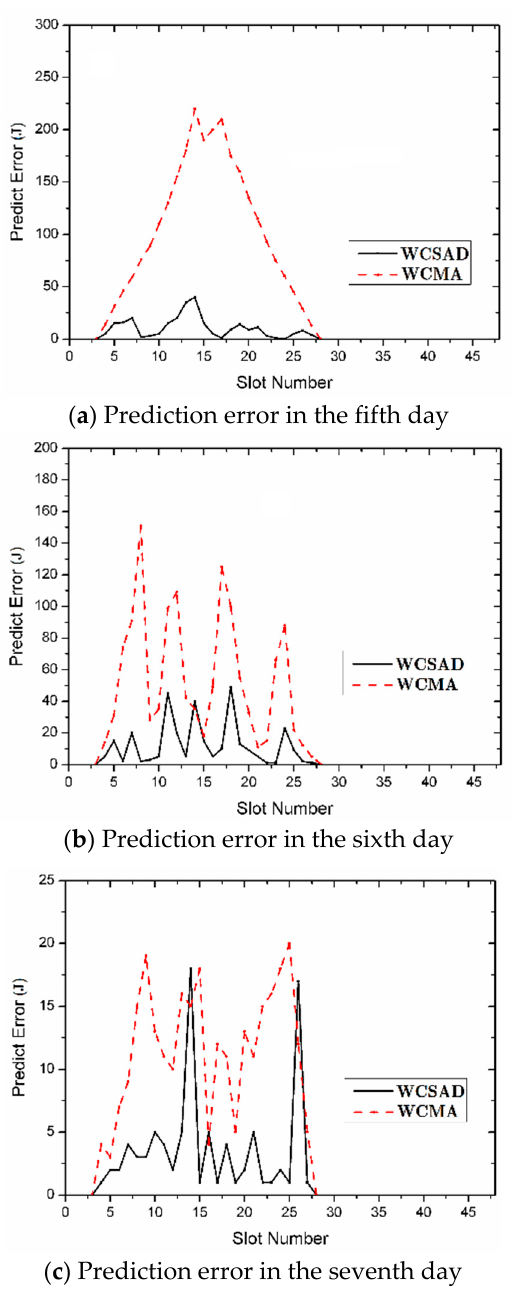
Figure 9. Error comparison result between Weather-Conditioned Selective Additive Decomposition (WCSAD) and WCMA.